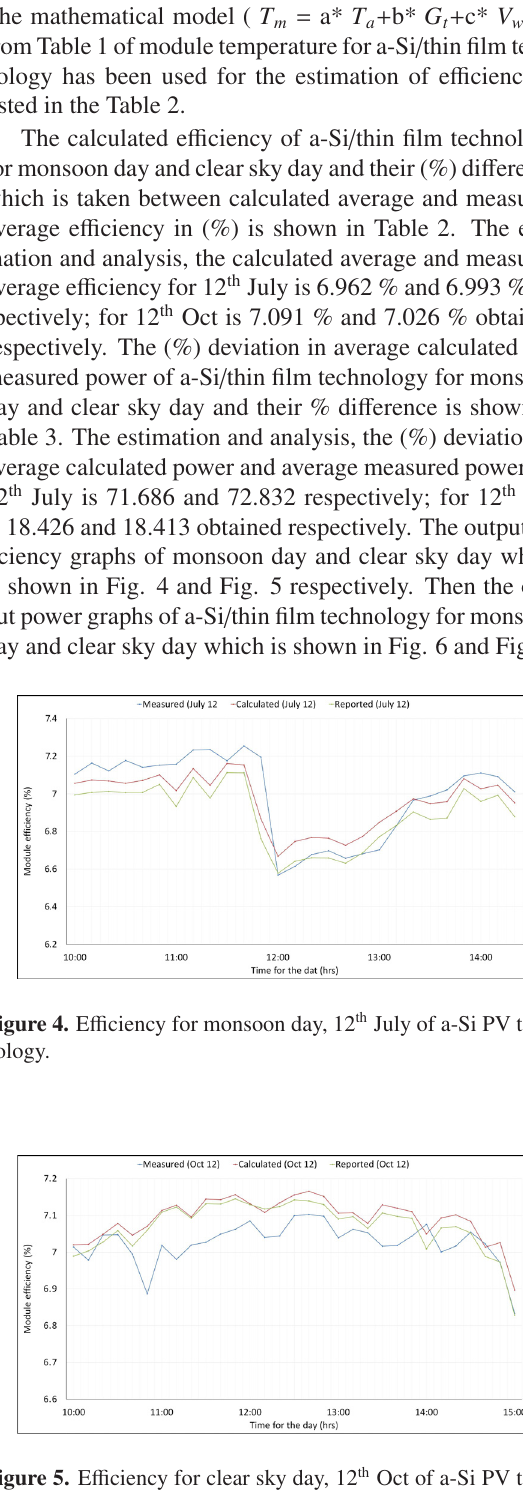
Figure 5. E ffi ciency for clear sky day, 12 th Oct of a-Si PV tech- nology.